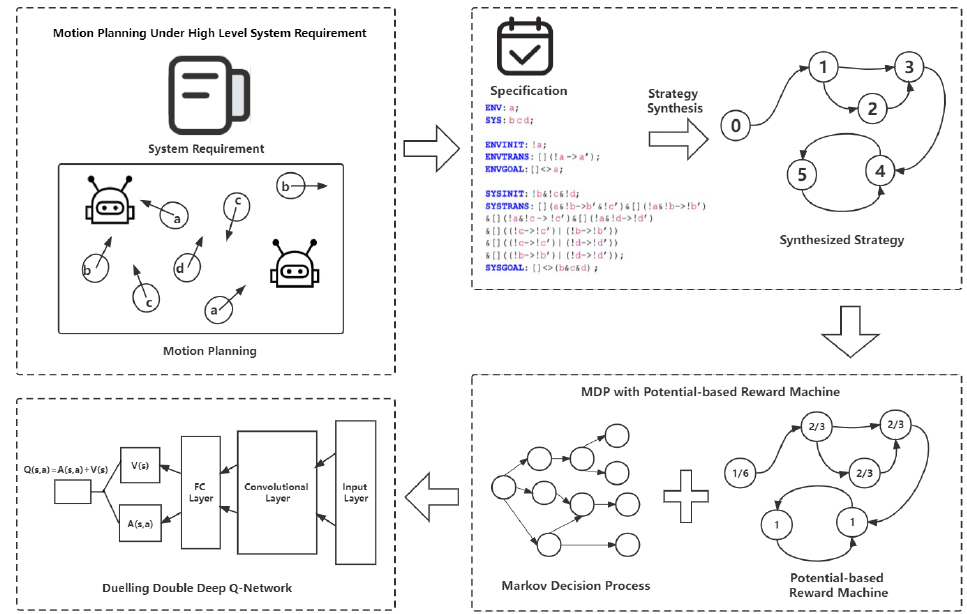
Figure 3. Overall Framework that Guides Deep Reinforcement Learning with High-level GR(1)